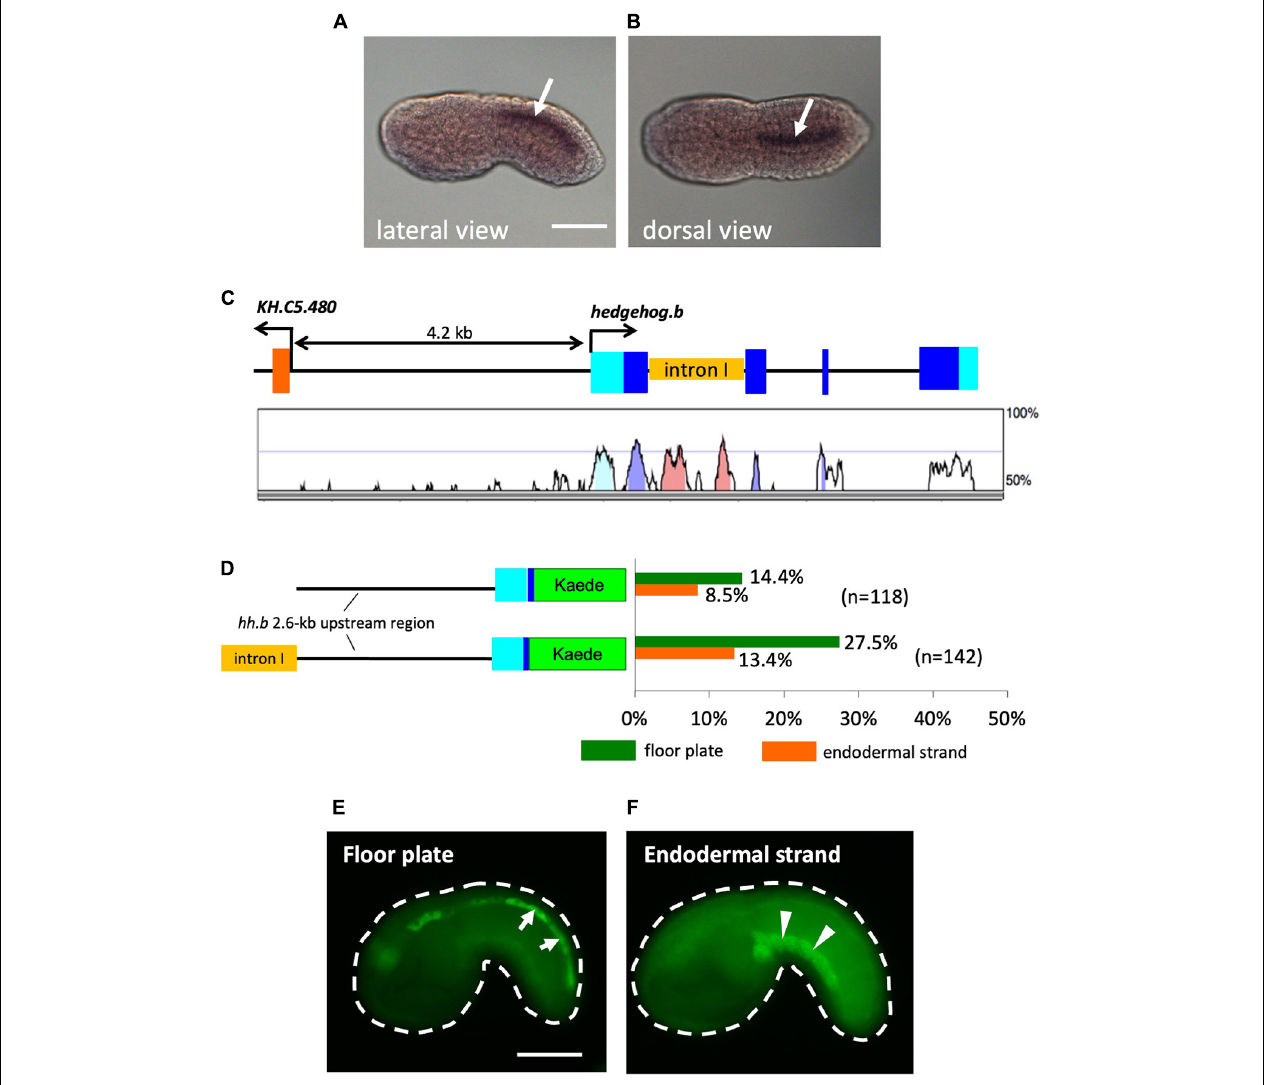
FIGURE 1 | Activity of cis -regulatory regions of Ciona hedgehog.b in the floor plate and the endodermal strand of tail bud embryos. (A,B) Expression pattern of hedgehog.b at the tailbud stage visualized by whole-mount in situ hybridization. Anterior is to the left. Arrows indicate the floor plate (ventral nerve cord). (A) Lateral view. (B) Dorsal view. (C) Genomic organization of the hedgehog.b gene. The exons are indicated by boxes in cyan (untranslated regions) and blue (coding regions). The untranscribed regions and introns are indicated by lines. A peaks-and-valleys graph below the genomic organization diagram is a VISTA profile (Frazer et al., 2004) showing the percent conservation of the nucleotide sequence of each region between C. intestinalis type A and Ciona savignyi . (D) The structure of the Kaede reporter constructs and the reporter expression patterns observed. The left diagrams show schematic structure of each construct. Cyan and blue boxes indicate the 5 (cid:48) untranslated region and a partial coding region, respectively, of hedgehog.b . The orange box indicates the first intron sequence of hedgehog.b . Bars in the right graph show the percentage of larvae with Kaede expression in a tissue out of all electroporated embryos scored for each construct. Different colors of bars represent expression in different tissues: green, floor plate; orange, endodermal strand. Numbers in parentheses indicate the number of larvae scored for each construct. (E,F) Examples of mid tailbud embryos electroporated with the hedgehog.b (+int) > kaede construct showing Kaede expression in the floor plate (arrows in panel E) and the endodermal strand (arrowheads in panel F) . Scale bars, 50 µ